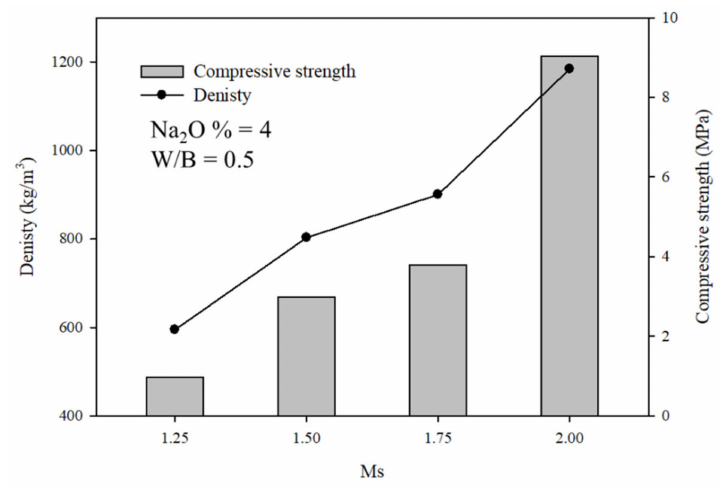
Figure 4. Density and compressive strength of porous materials made from different Ms (Na 2 O% = 4%, W/B = 0.5, Al powder = 0.2%, LS replacement =